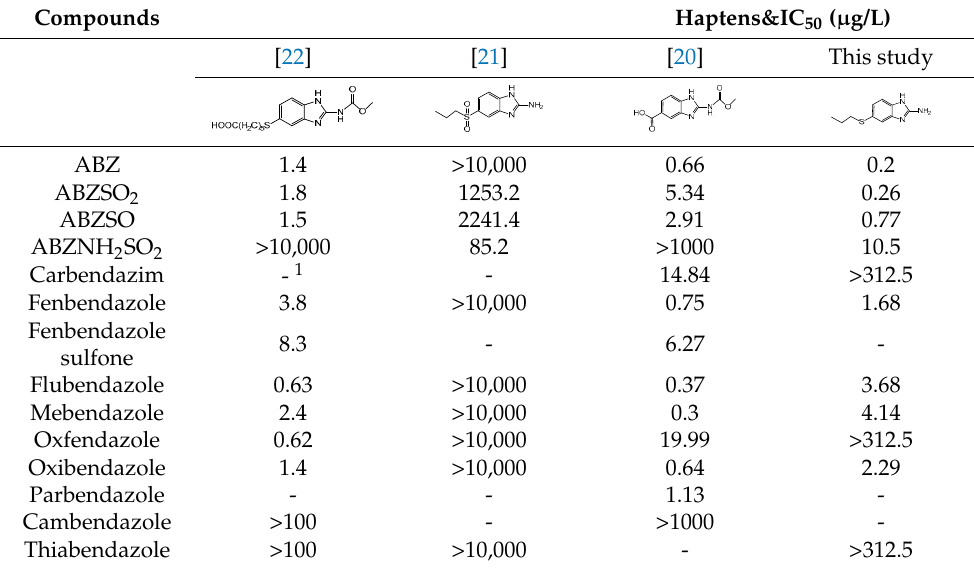
Table 1. Specificities of reported antibodies against ABZs in the literatures. Compounds